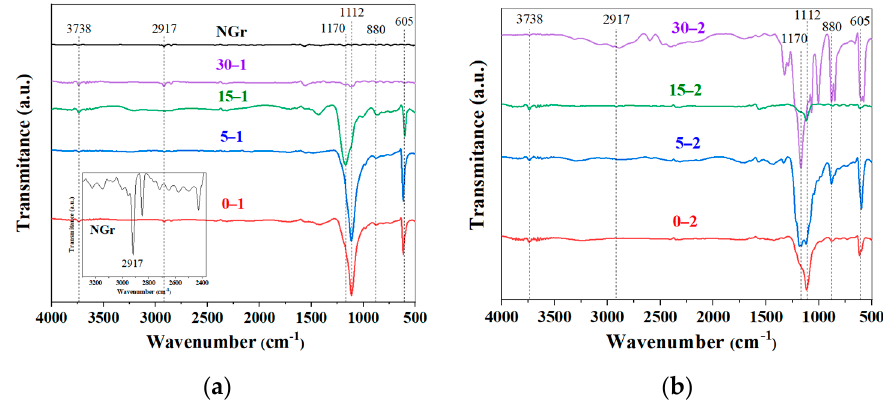
Figure 4. FTIR spectra of raw graphite and intercalated materials: ( a ) 30% and ( b ) 50% H 2 O 2